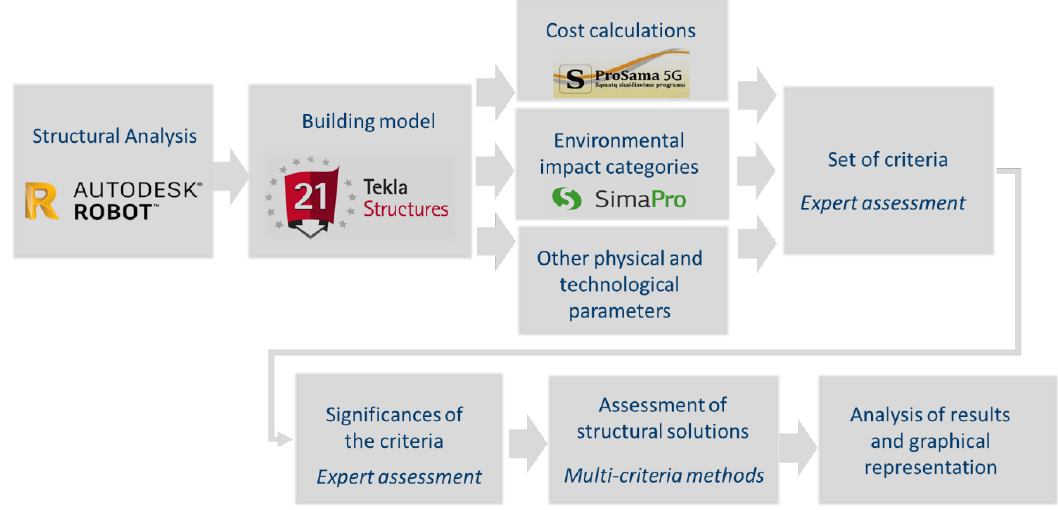
Figure 6. Information flow for the analysis of real case building.